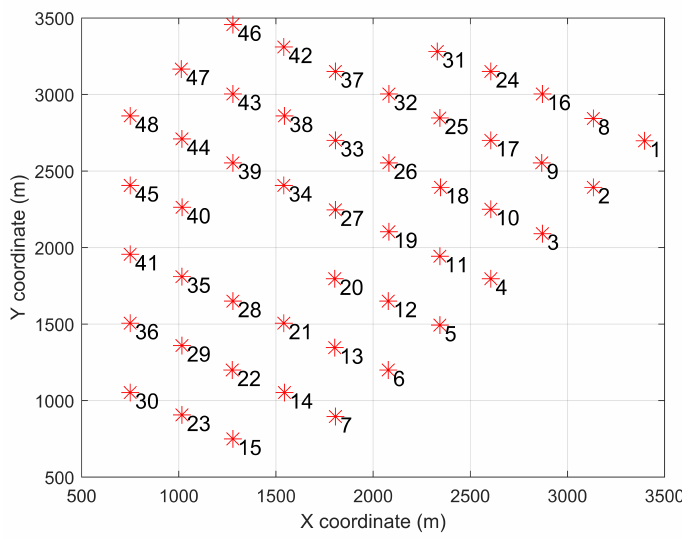
Figure 2. Lillgrund’s